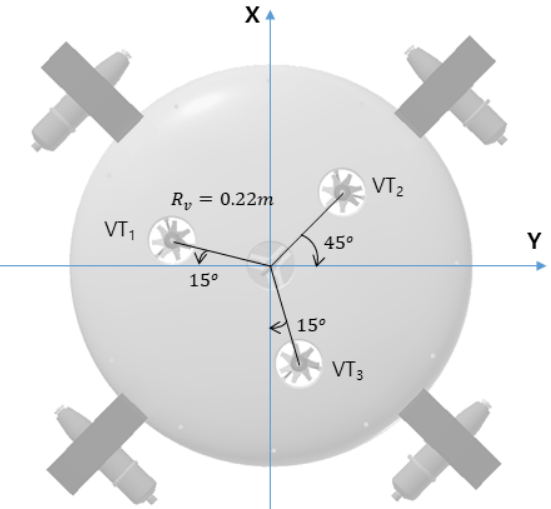
Figure 4. Vertical thrusters